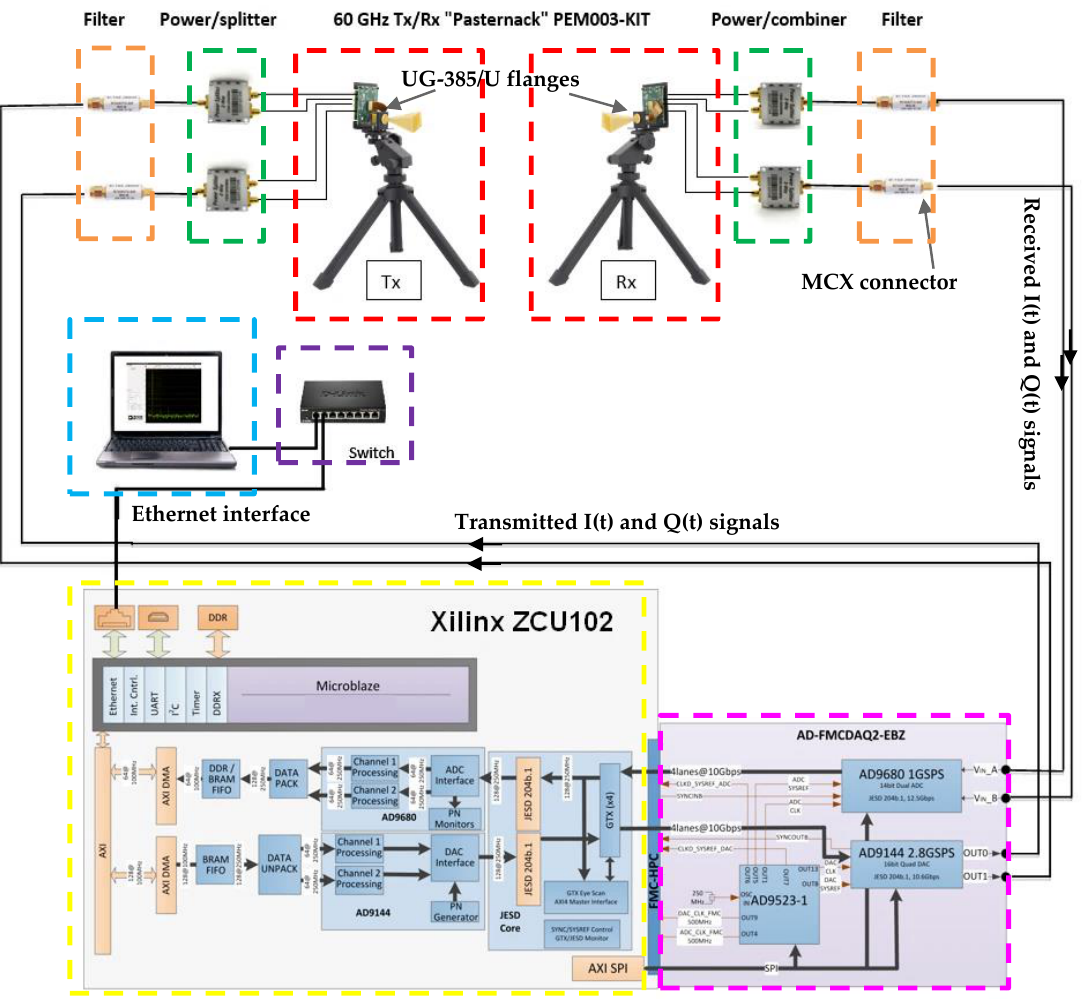
Figure 5. Demonstrator of the “Wireless Connector” system based on the RF-PEM003, ZCU102 and FMCDAQ2 components.